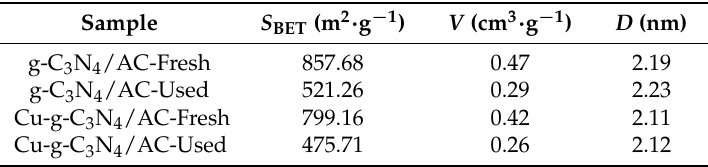
Table 3. Texture parameters of the catalysts.